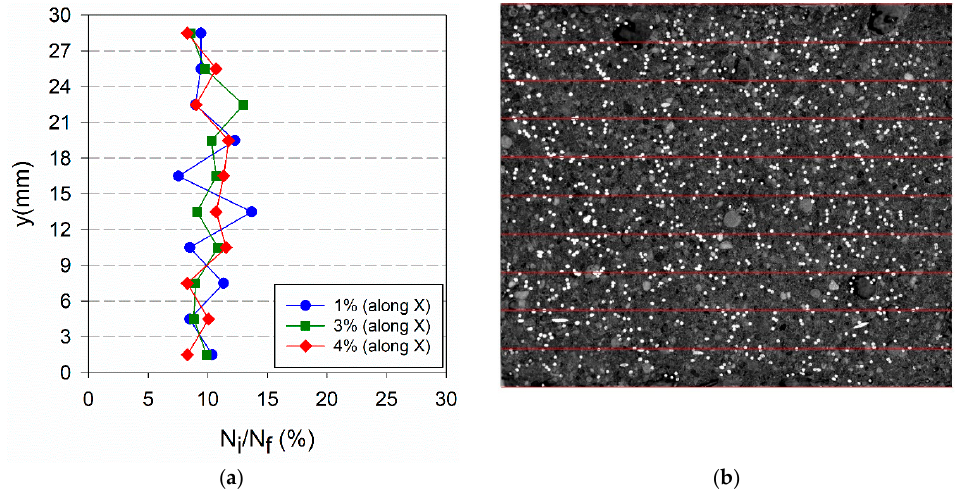
Figure 18. ( a ) Fibre distribution along the plate thickness (X-direction) for HO_i specimens; ( b ) image of HO_4% specimen along X-direction.